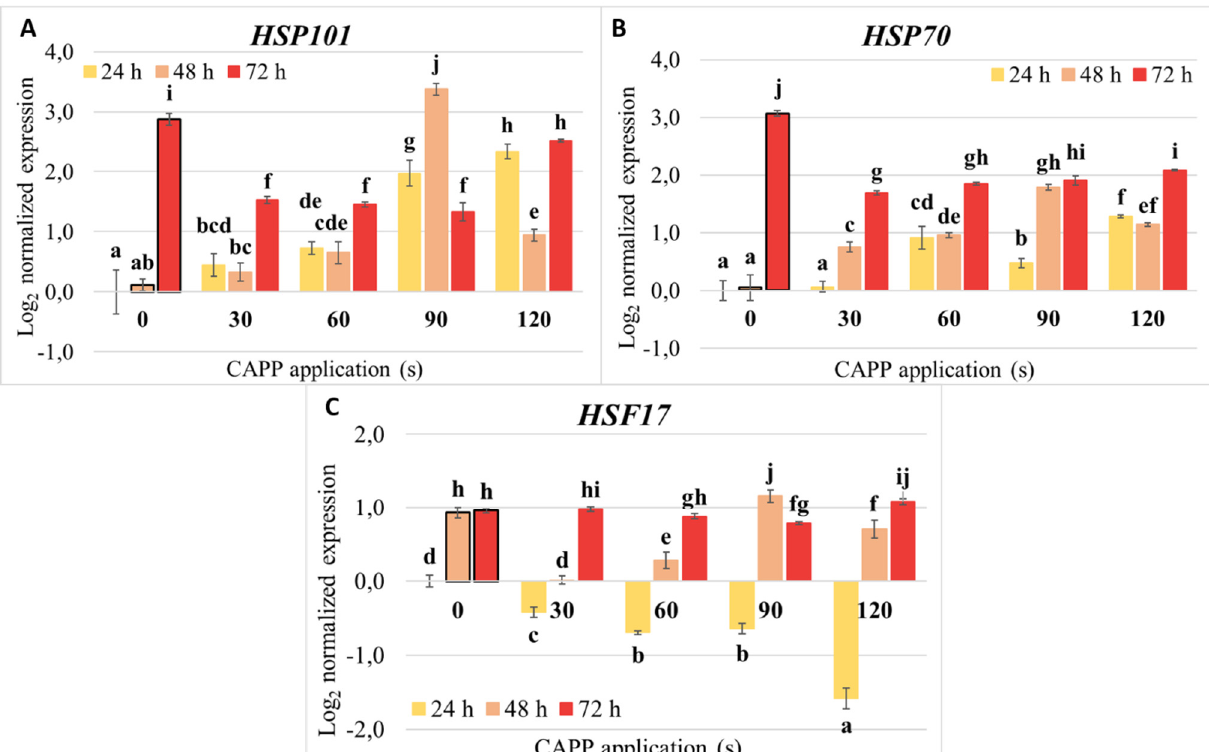
Figure 8. The relative expression of HSP101 ( A ), HSP70 ( B ) and HSF17 ( C ) in maize seedlings, which were treated with Cold Atmospheric Pressure Plasma (CAPP) generated in ambient air as grains for 0, 30, 60, 90 and 120 s, detected at 24, 48 and 72 h after sowing. Data are normalized to reference genes—tubulin β and elongation factor EF1 α . The data were analyzed using the statistical method LSD ANOVA and comparisons between the mean values were considered significant at p 0.05. Different letters indicate significant differences between the treatments at p -value < 0.05 level.